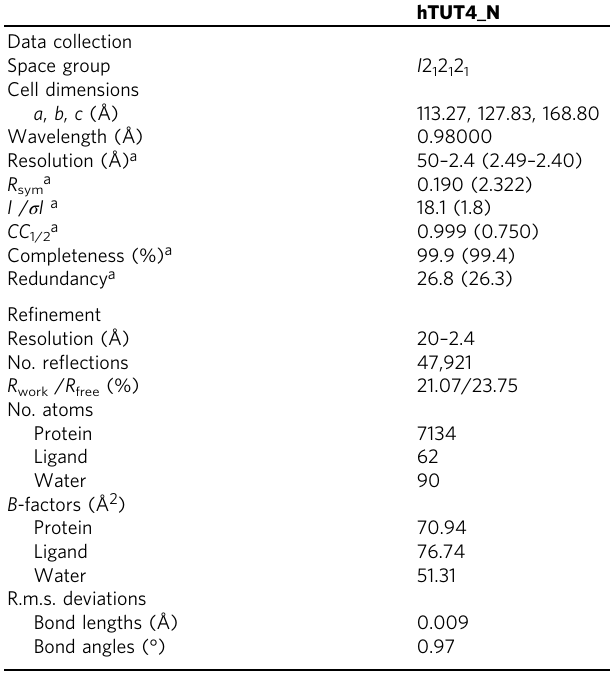
Table 1 Data collection and re fi nement statistics